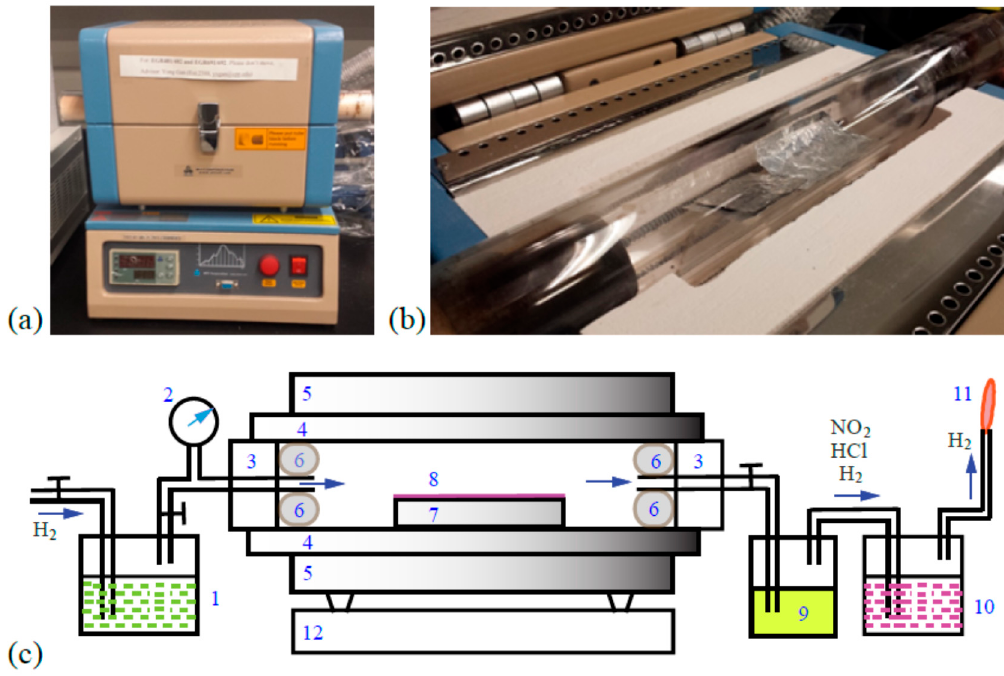
Figure 1. The chemical vapor deposition set-up and the schematic of the chemical vapor deposition (CVD) process: ( a ) split furnace; ( b ) reaction chamber; ( c ) illustration of the chemical vapor deposition process. 1: precursor solution; 2: vacuum pump; 3: sealing flanges; 4: ceramic tube; 5: heating unit; 6: ceramic foam insulating block; 7: anodic aluminum oxide (AAO) substrate; 8: Bi-Te-Ni-Cu-Au coating; 9: cold trap; 10: sodium hydroxide solution; 11: gas torch; and 12: control unit.